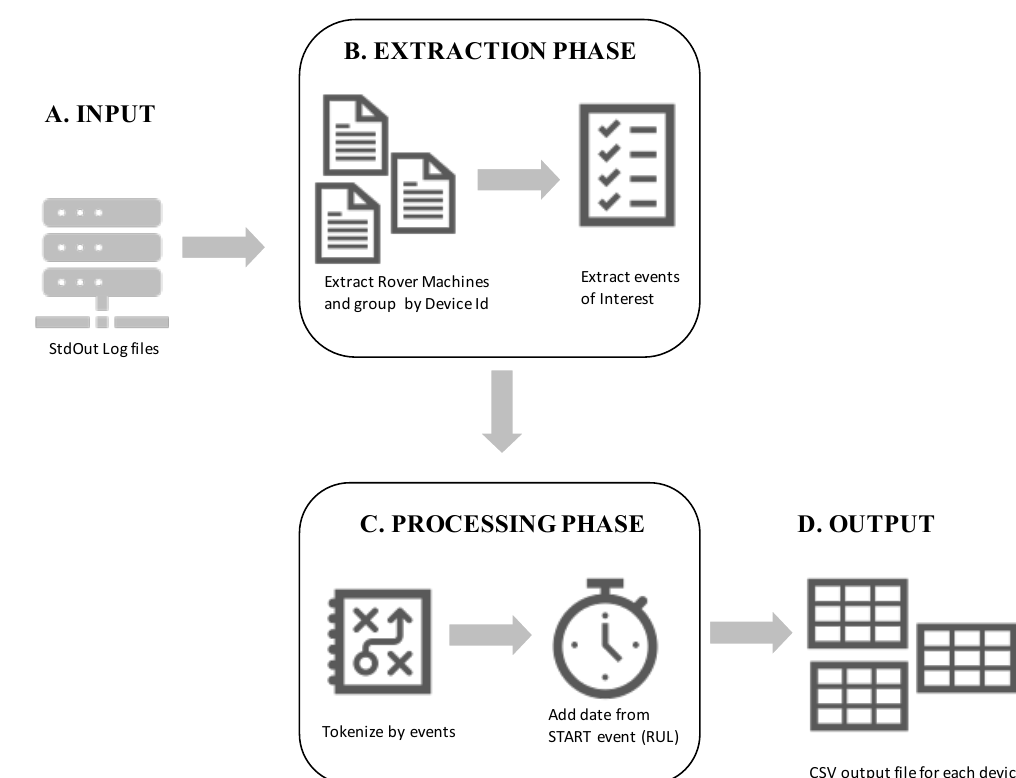
Figure 3. Parser Flowchart development Flowchart diagram indicates the phases of the parser development ( A , B ) During the extraction phase, unstructured stdout log file we collected for each device and parsed to extract events of interest and timestamp. ( C , D ) In the processing phase, the extracted event triggers and timestamp were tokenized and formatted into .csv output for each Rover device.